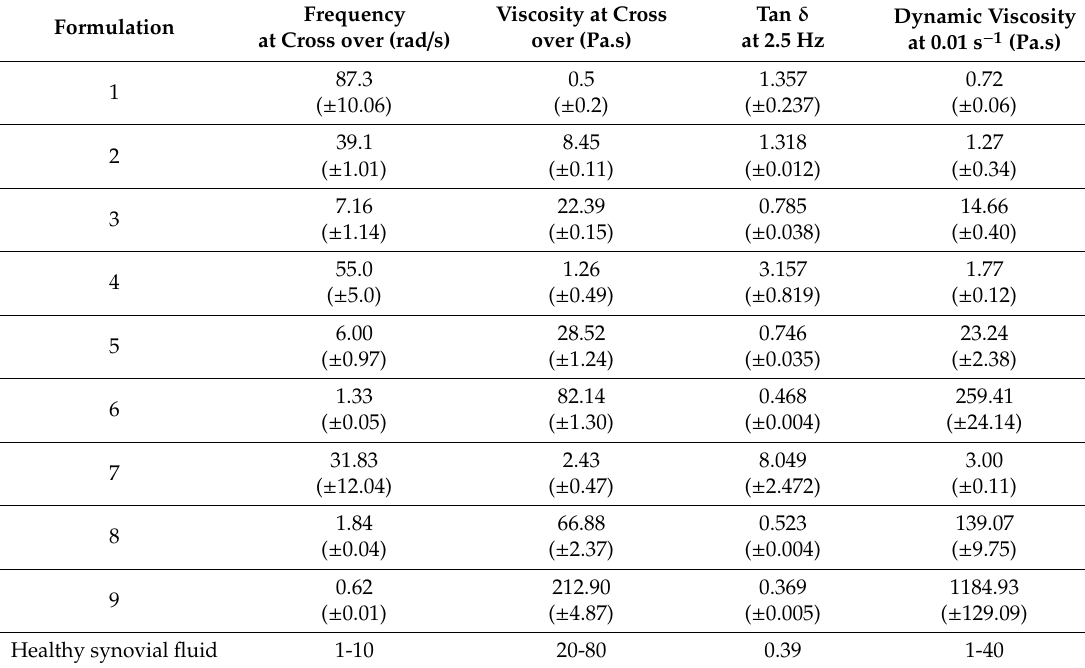
Table 3. Response variables of the formulations of the full factorial design (mean values ± s.d.; n = 3). Frequency Viscosity at Cross Formulation at Cross over (rad / s) over